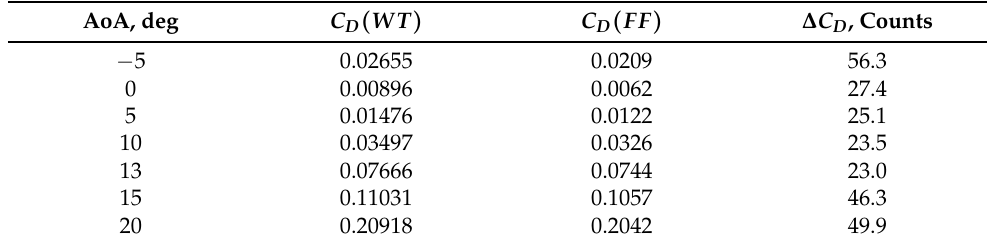
Table 4. Reynolds number effect over drag coefficient.